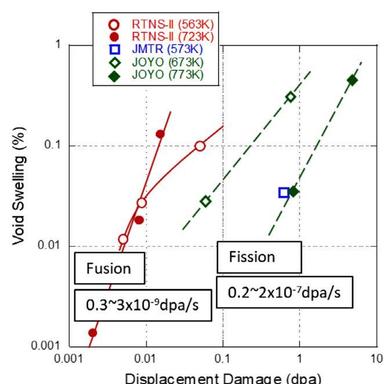
Void swelling in nickel as a function of dpa, comparing RTNS-II at 563 K and JMTR at 573 K , and RTNS-II at 723 K and JOYO at 673 K or 773 K .